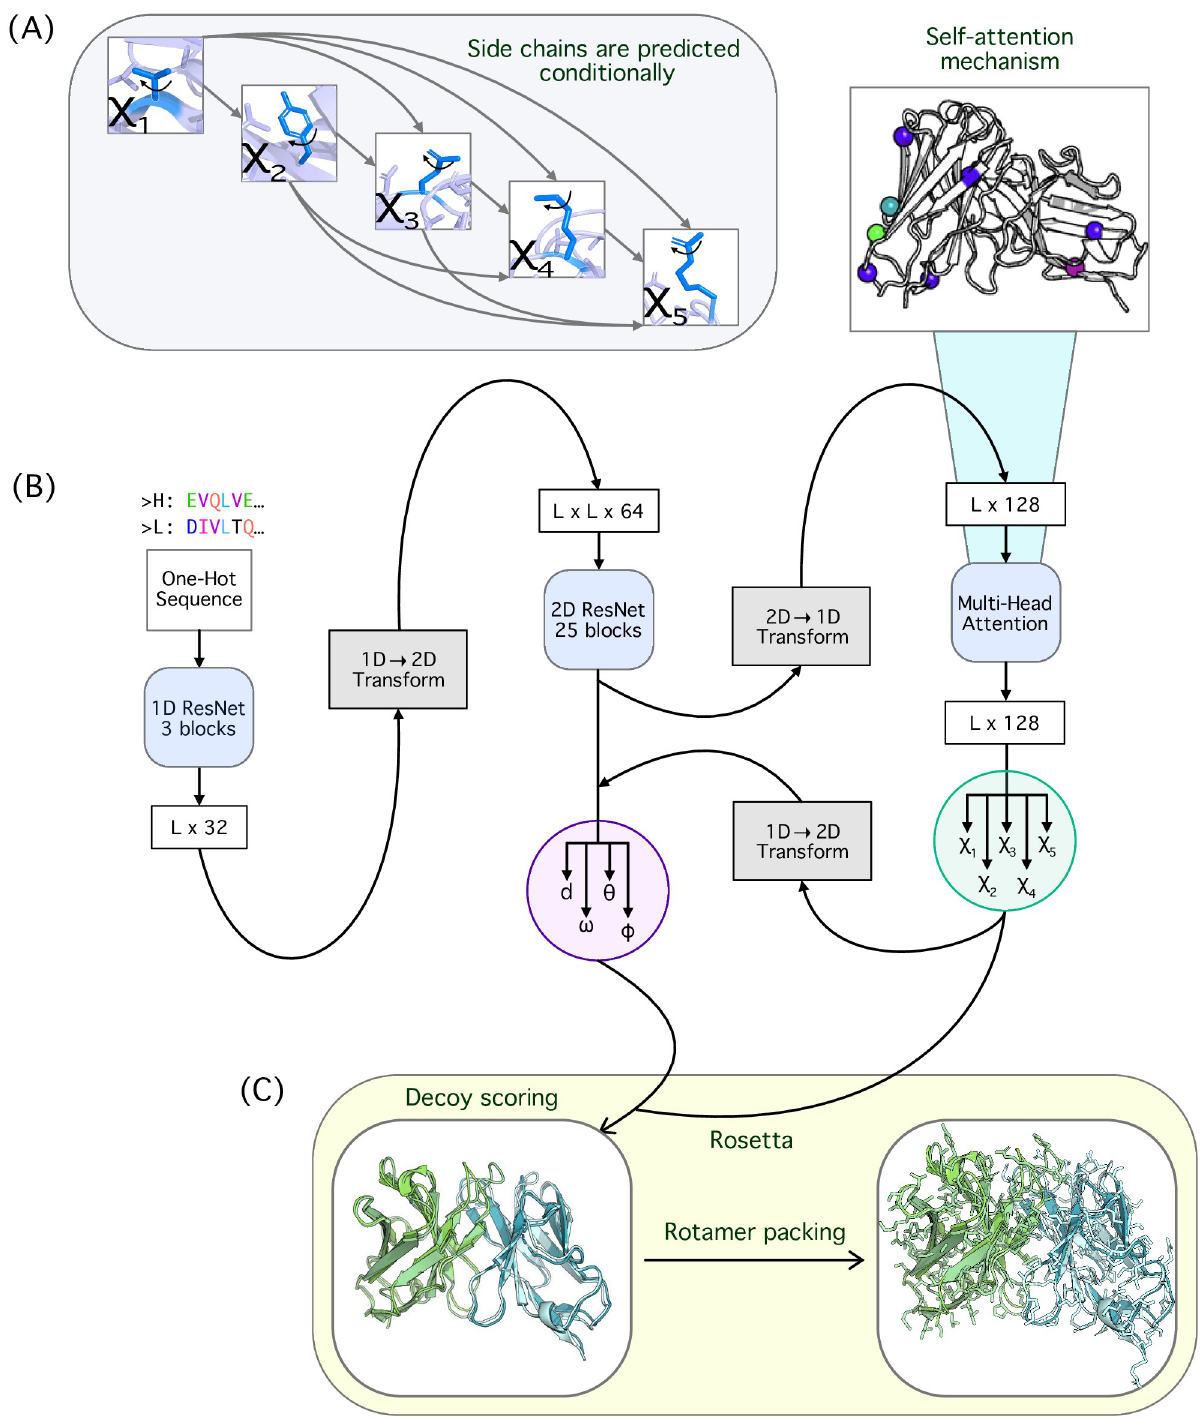
Fig 1. Overview of the DeepSCAb network architecture. (A) Conditional side-chain dihedral prediction in DeepSCAb rotamer module with each dihedral after χ 1 depending on previous prediction(s). (B) DeepSCAb architecture for predicting inter-residue geometries and side-chain dihedrals. (C) Applications of DeepSCAb for full F V realizations and side-chain repacking using Rosetta.